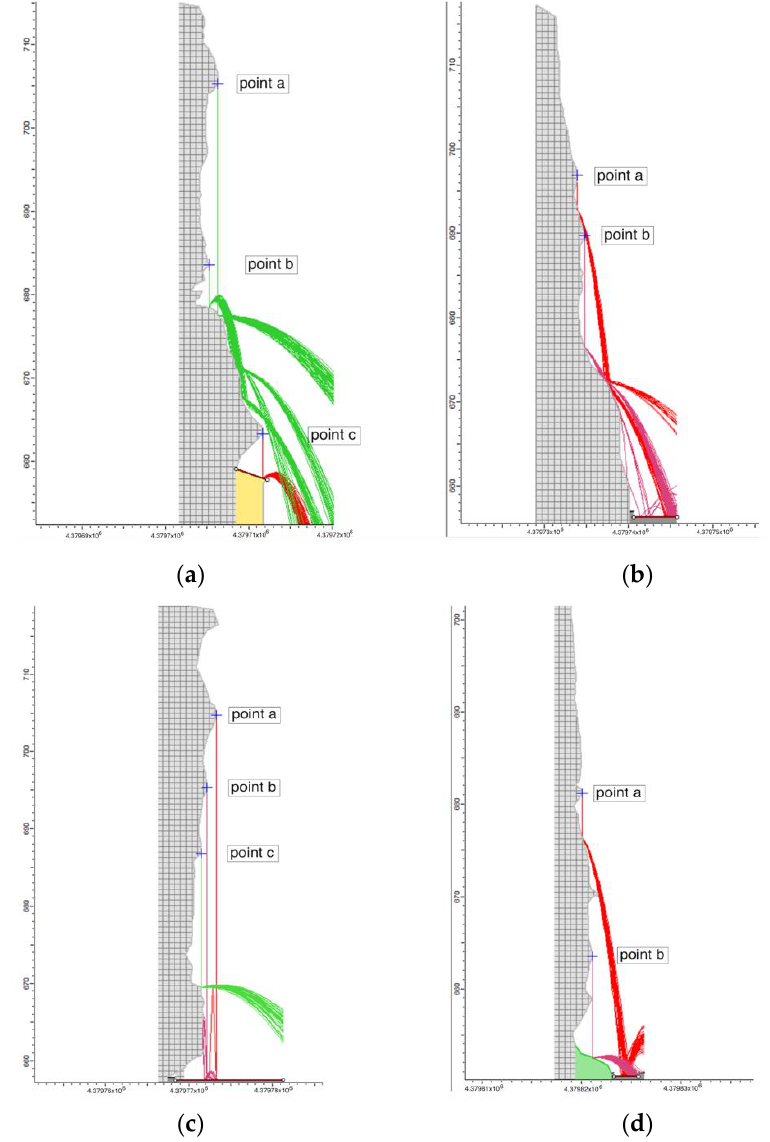
Figure 20. Location of main release points for rock blocks (seeders) and the trajectories of the potential blocks for: ( a ) sub-region U1 ( b ) sub-region U2 ( c ) sub-region U3 and ( d ) sub-region U4.